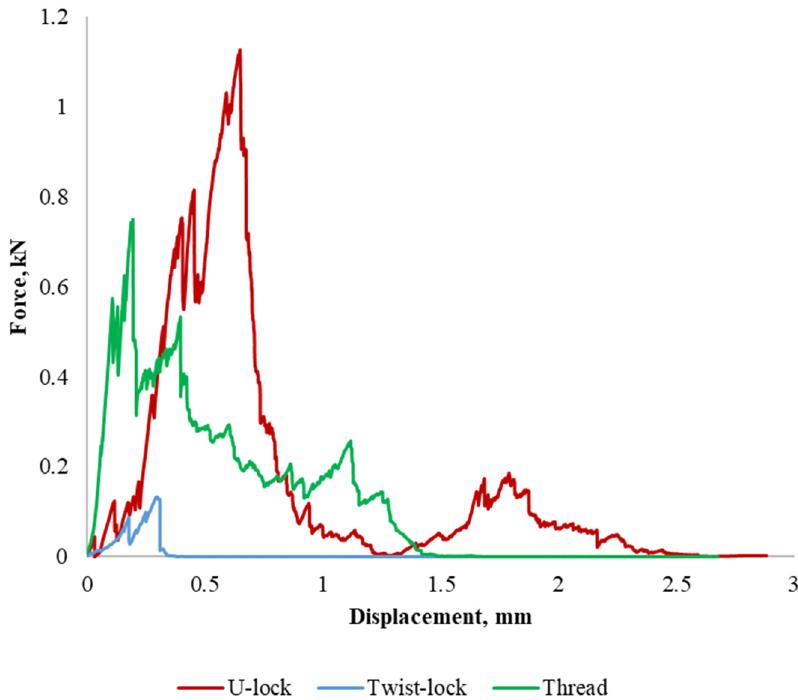
Figure 9. Force–displacement relationship for the interlocking mechanisms.